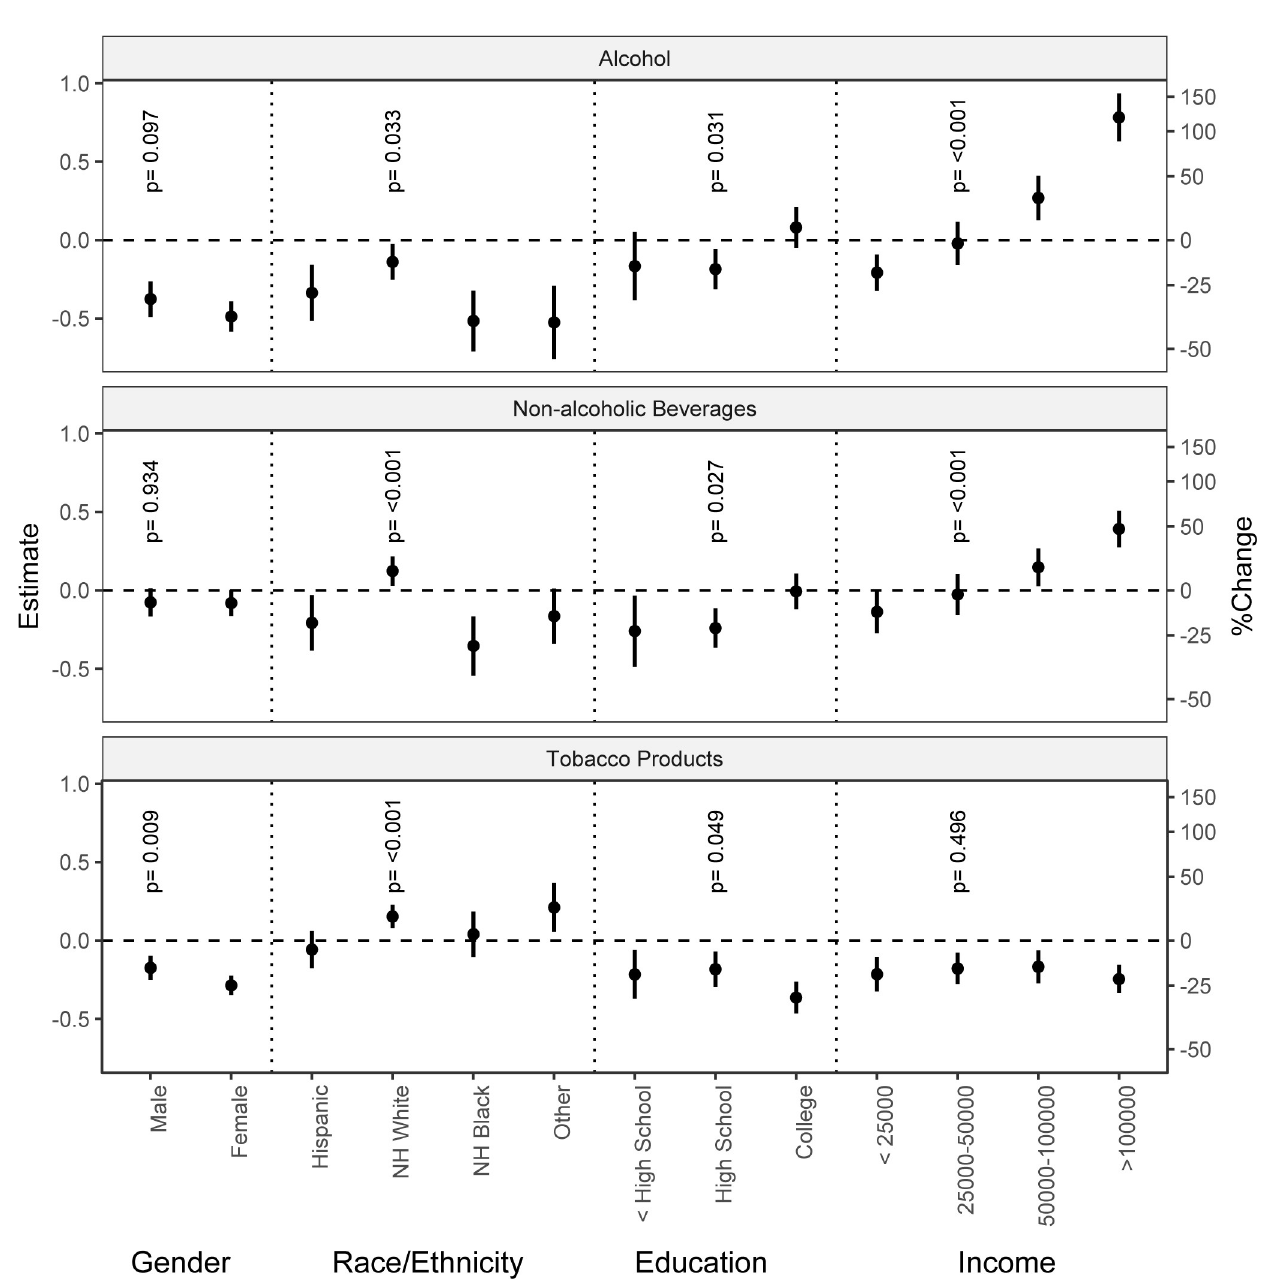
Fig 2. Changes in spending (estimate and 95% CI) by expenditure categories and socio-economic groups during the pandemic estimated from the interaction models. The p-values represent the test of similarity in expenditure in the pandemic period within categories of the given socio-economic group (gender, race/ethnicity, education,